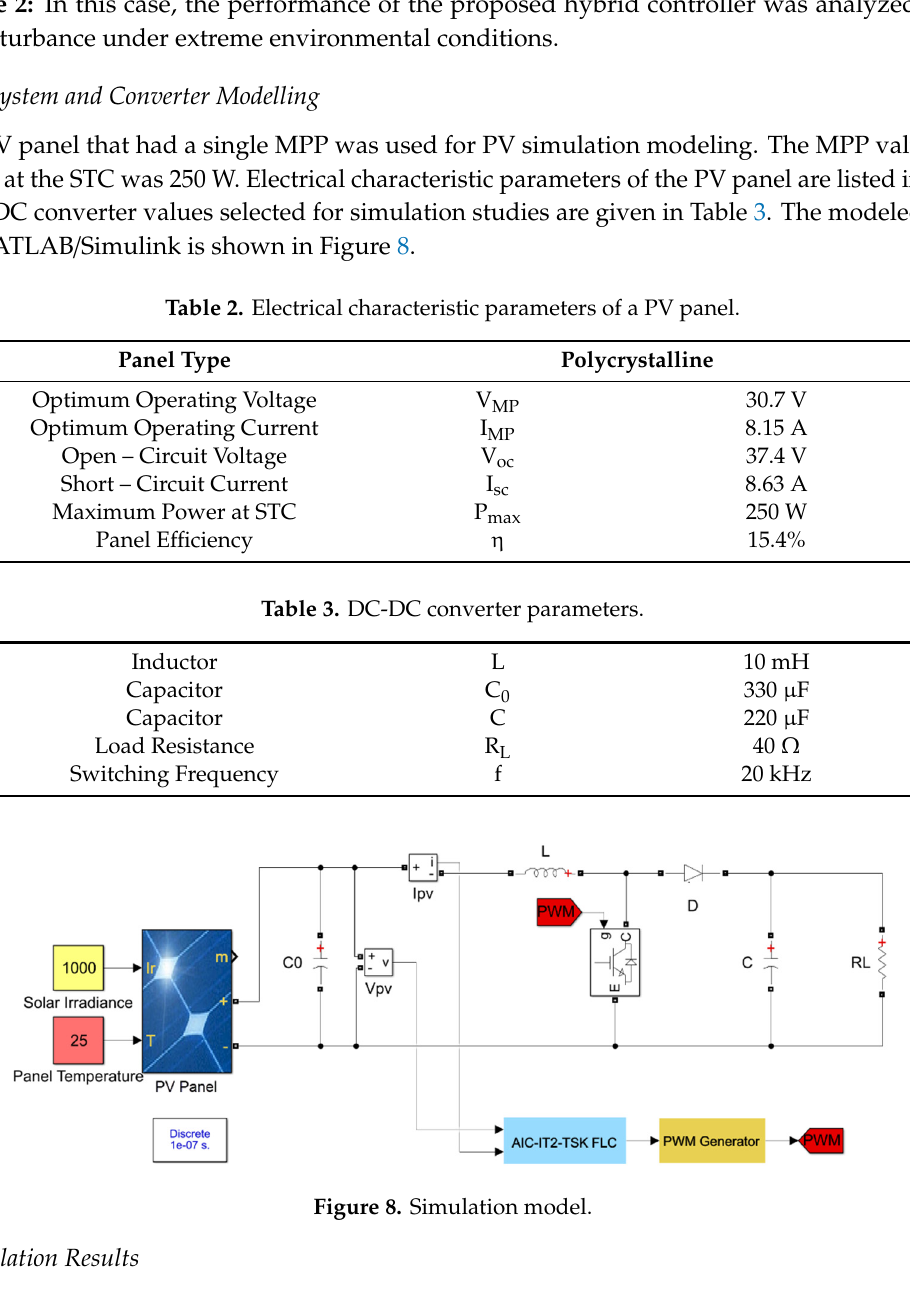
Table 3. DC-DC converter parameters. Inductor